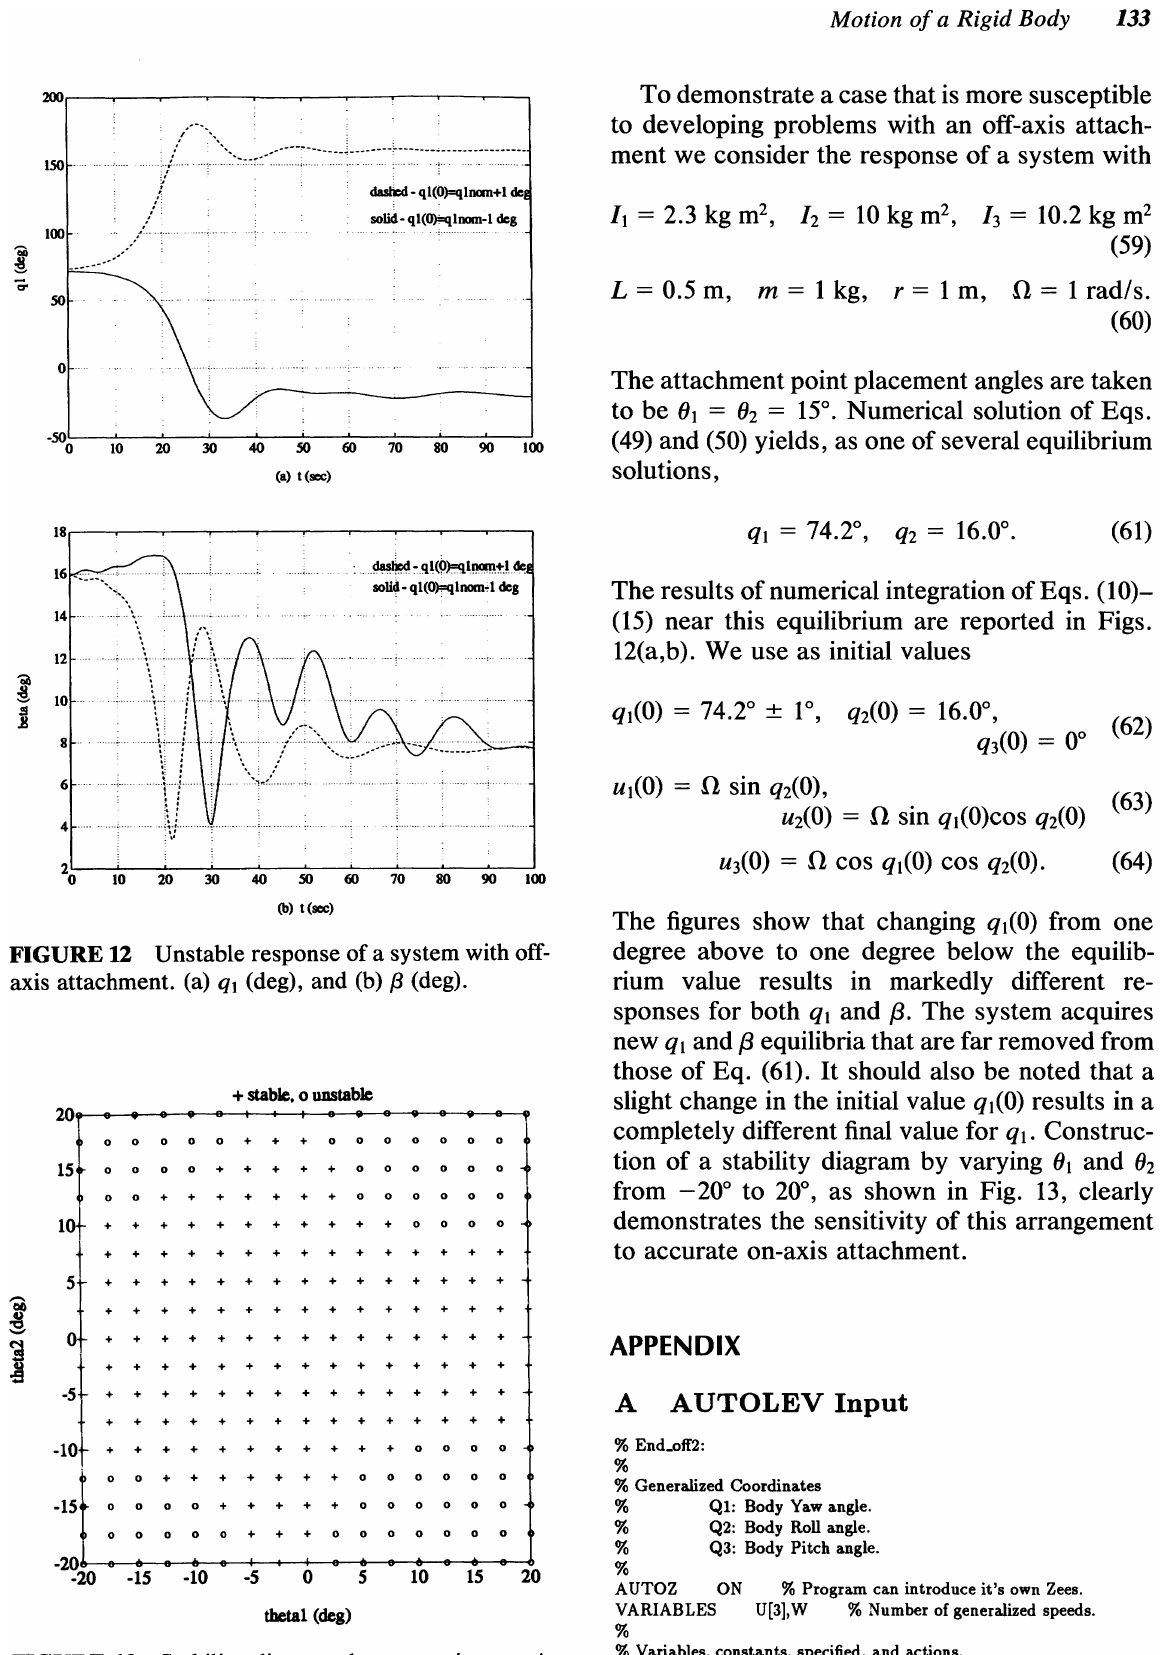
FIGURE 13 Stability diagram demonstrating sensi tivity to off-axis